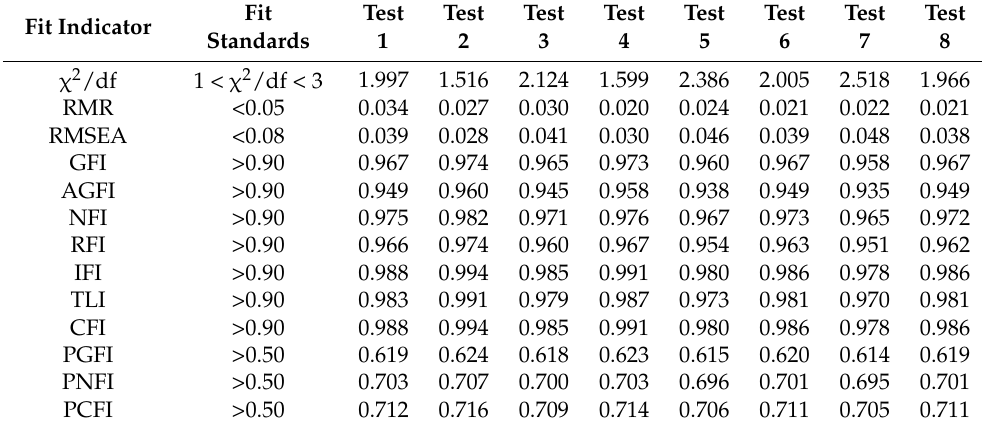
Table 2. Structural equation model fit